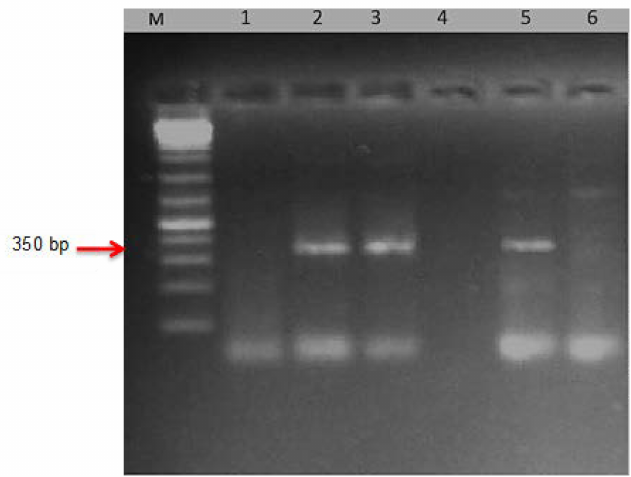
Figure 6. Electrophoretic amplified pattern of DNA extracted from six races of Puccinia graminis using the specific primer for Ug99 . M= DNA Ladder (DNA Marker), Lane 1 = Race isolated from the line with Sr24 gene; Lane 2 = Race isolated from the line with Sr31 gene; Lane 3 = Race isolated from Clement (with Sr31 gene); Lane 4 = Race isolated from the line with Sr38 ; Lane 5 = Race isolated from Brigardier (with Sr31 gene); and Lane 6 = Race isolated from the line Fleming (with Sr6, Sr24, Sr36, and 1RS-Am